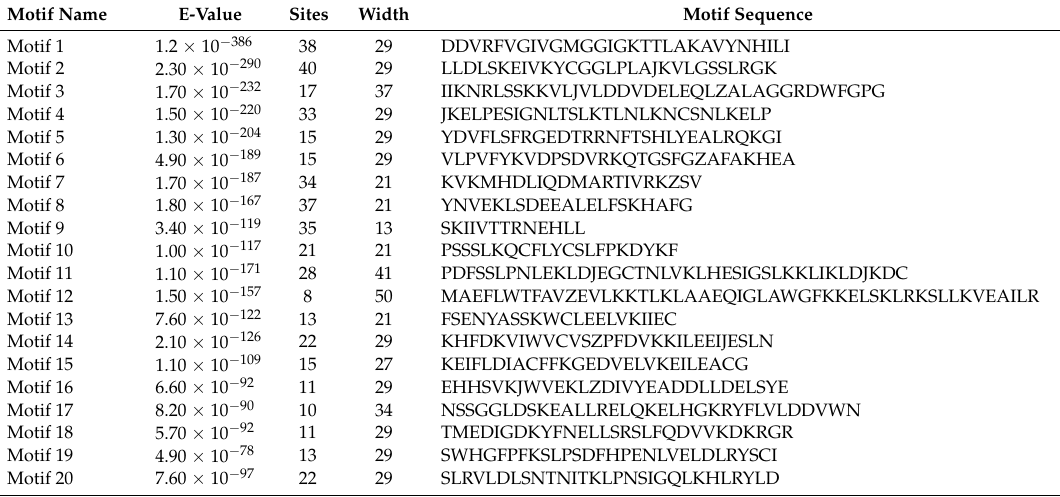
Figure 4. Conserved motifs of NBS-encoding R genes in the watermelon genome. Motifs are indicated by different colored rectangles. Detailed information is provided in Table 4. Table 4. Putative conserved motifs in the 44 watermelon NBS proteins.